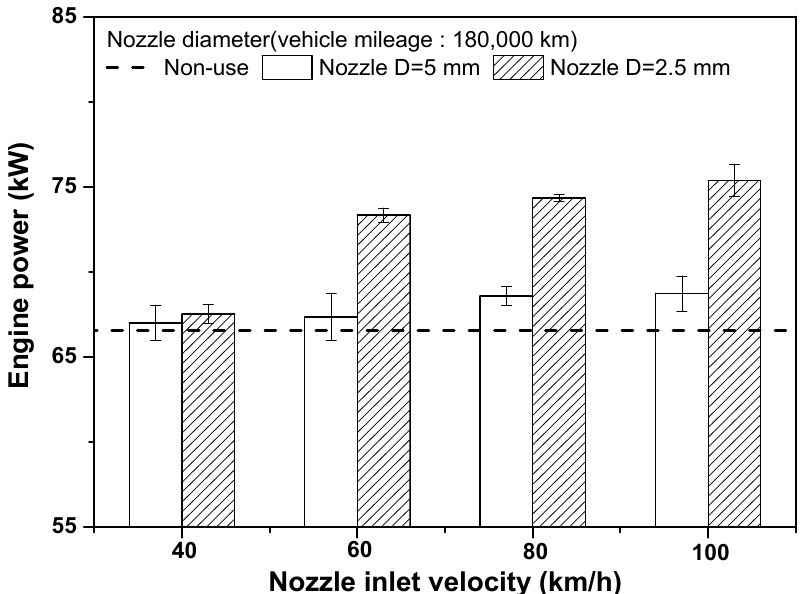
Figure 7. Comparison of the engine power according to nozzle diameter for the 180,000 km mileage engine.